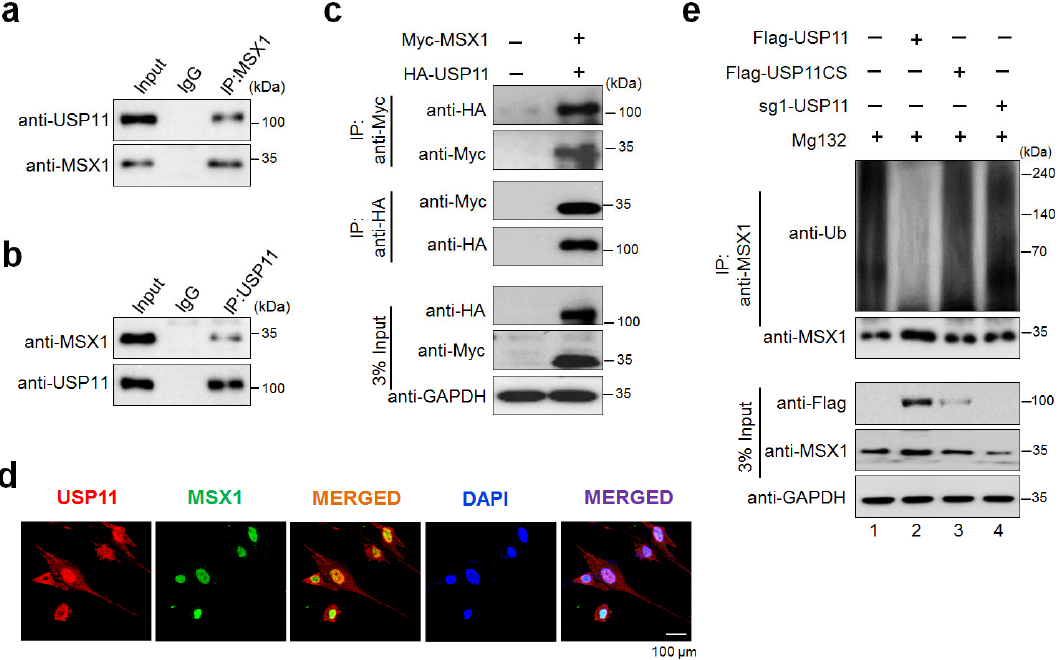
Figure 3. USP11 interacts and deubiquitinates MSX1 protein. ( a , b ) Interaction between endogenous USP11 and MSX1 proteins was evaluated in hMSCs. Cell lysates from hMSCs were immunoprecipitated with specific MSX1 ( a ) or USP11 antibodies ( b ) and immunoblotted with the indicated antibodies. ( c ) Myc ‐ MSX1 and HA ‐ USP11 were co ‐ transfected in HEK293 cells. Samples were immunoprecipitated using anti ‐ Myc or anti ‐ HA antibodies and immunoblotted using the indicated antibodies. GAPDH was used as a loading control. ( d ) An immunofluorescence assay was performed to determine the localization of MSX1 and USP11 proteins. DAPI was used as a nuclear stain. ( e ) The endogenous deubiquitination of MSX1 was analyzed by transfecting hMSCs with Flag ‐ USP11, Flag ‐ USP11CS, and sgRNA targeting USP11 , followed by immunoprecipitation with anti ‐ MSX1 antibody and immunoblotting with anti ‐ MSX1 or anti ‐ ubiquitin antibodies. The cells were treated with MG132 for 6 h prior to harvest for all experiments.